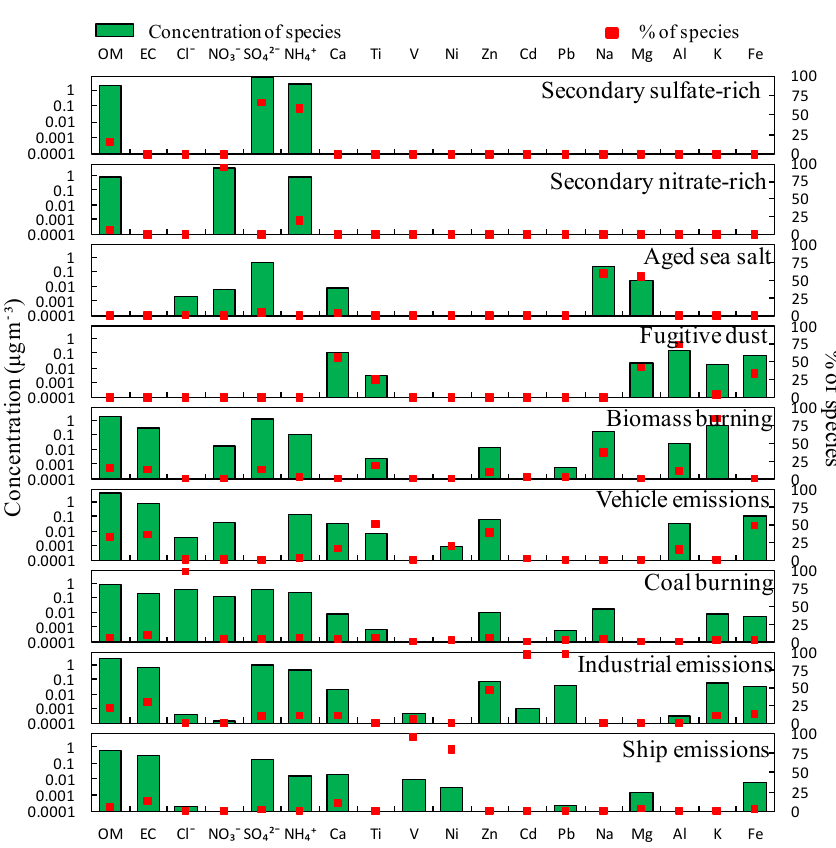
Figure 4. The factor profiles and explained variations in the ME-2 modeling.